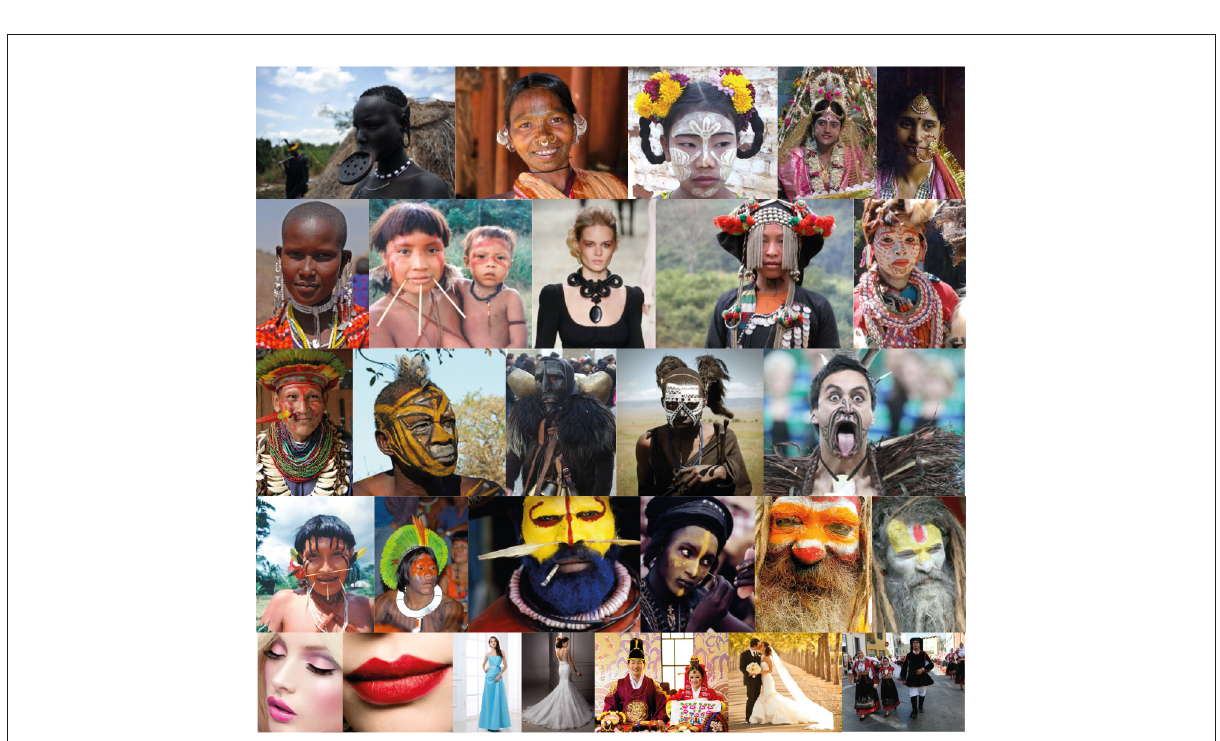
motion. By shaking the stimulus, the floating motion